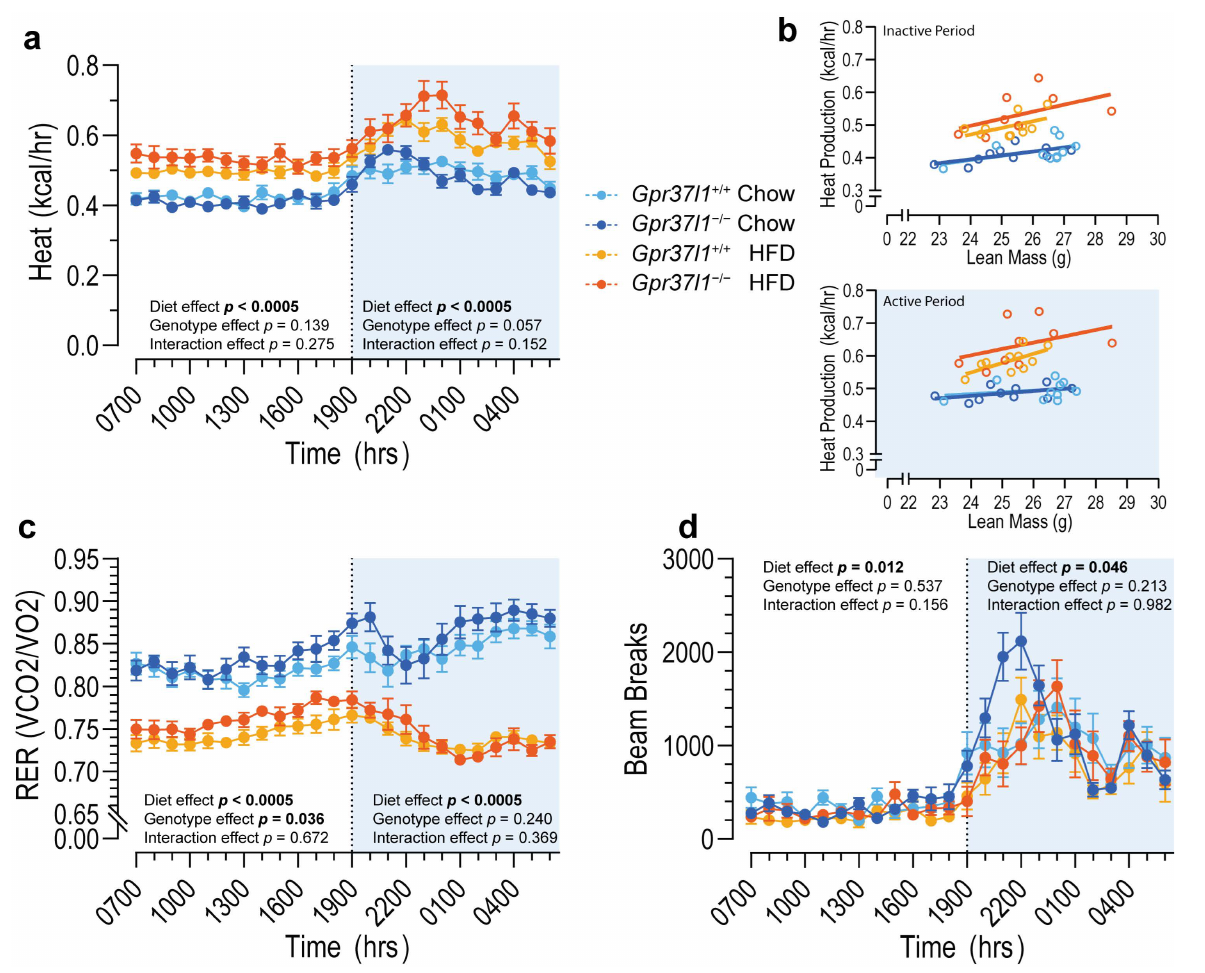
Figure 4. Metabolic profiling of diet-fed Gpr37l1 − / − and Gpr37l1 +/+ mice by indirect open-circuit calorimetry. At 17–18 weeks of age, and 8–9 weeks of either a chow or high-fat diet (HFD), male Gpr37l1 − / − and wildtype ( Gpr37l1 +/+ ) littermate mice were subjected to metabolic profiling using the Comprehensive Lab Animal Monitoring System (CLAMS). Mice were acclimated in the system for 24 h, followed by a 24 h period of data collection. Oxygen/CO 2 readings were taken every 20 min. ( a , b ) Heat production and ( c ) respiratory exchange ratio (RER) were derived from these measurements, and were processed into hourly averages. ( b ) Average heat production vs. lean mass for inactive (top panel) and active (bottom panel) periods. ( d ) Physical activity was measured by the number of infrared beam breaks in the XZ plane. Solid circles represent hourly averages for each experimental group; open circles represent individual subjects; error bars indicate SEM. Data analysed by repeated measures three-way ANCOVA (for ( a ); lean mass covariate) or by repeated measures three-way ANOVA ( c , d ) within each dark/light period (12 h). Significance was defined as p < 0.05 and denoted by bolded p value. Time is denoted in standard military time format; light period 0700–1900 (7 a.m.–7 p.m.). n = 9–10 subjects per group, 20 weeks